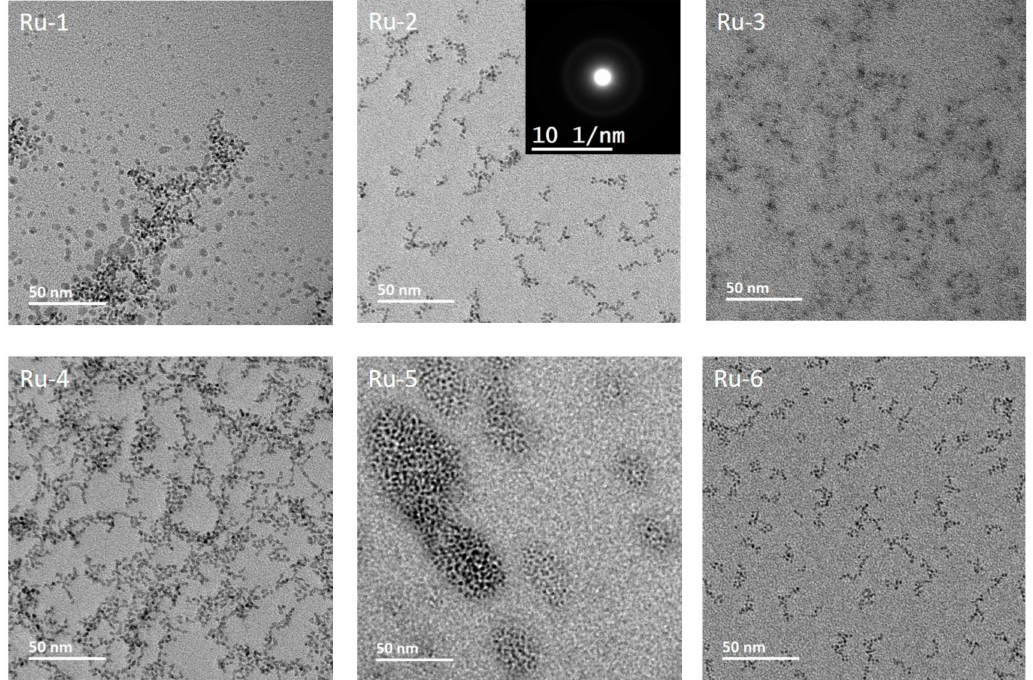
Figure 3. TEM micrographs of the as-synthesized Ru NPs labeled with the name of the respective samples. For the details of synthesis and labeling, see Table